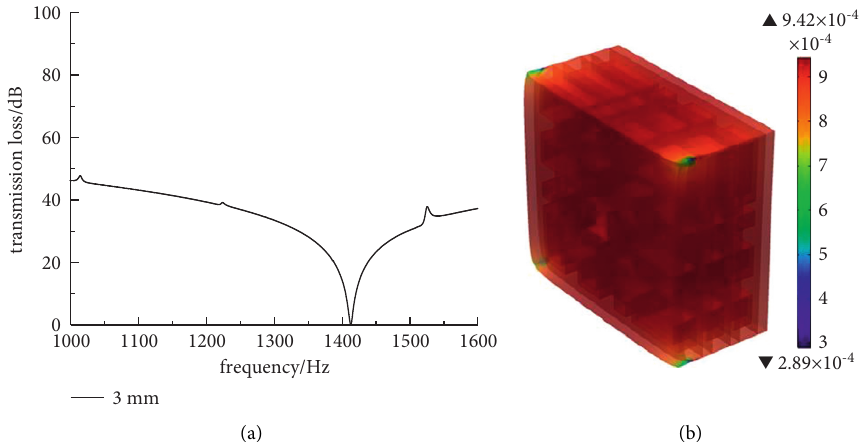
Figure 9: Sound insulation characteristics curve and vibration mode of metamaterials. (a) Sound insulation characteristics curve. (b) Vibration mode at 1412Hz.